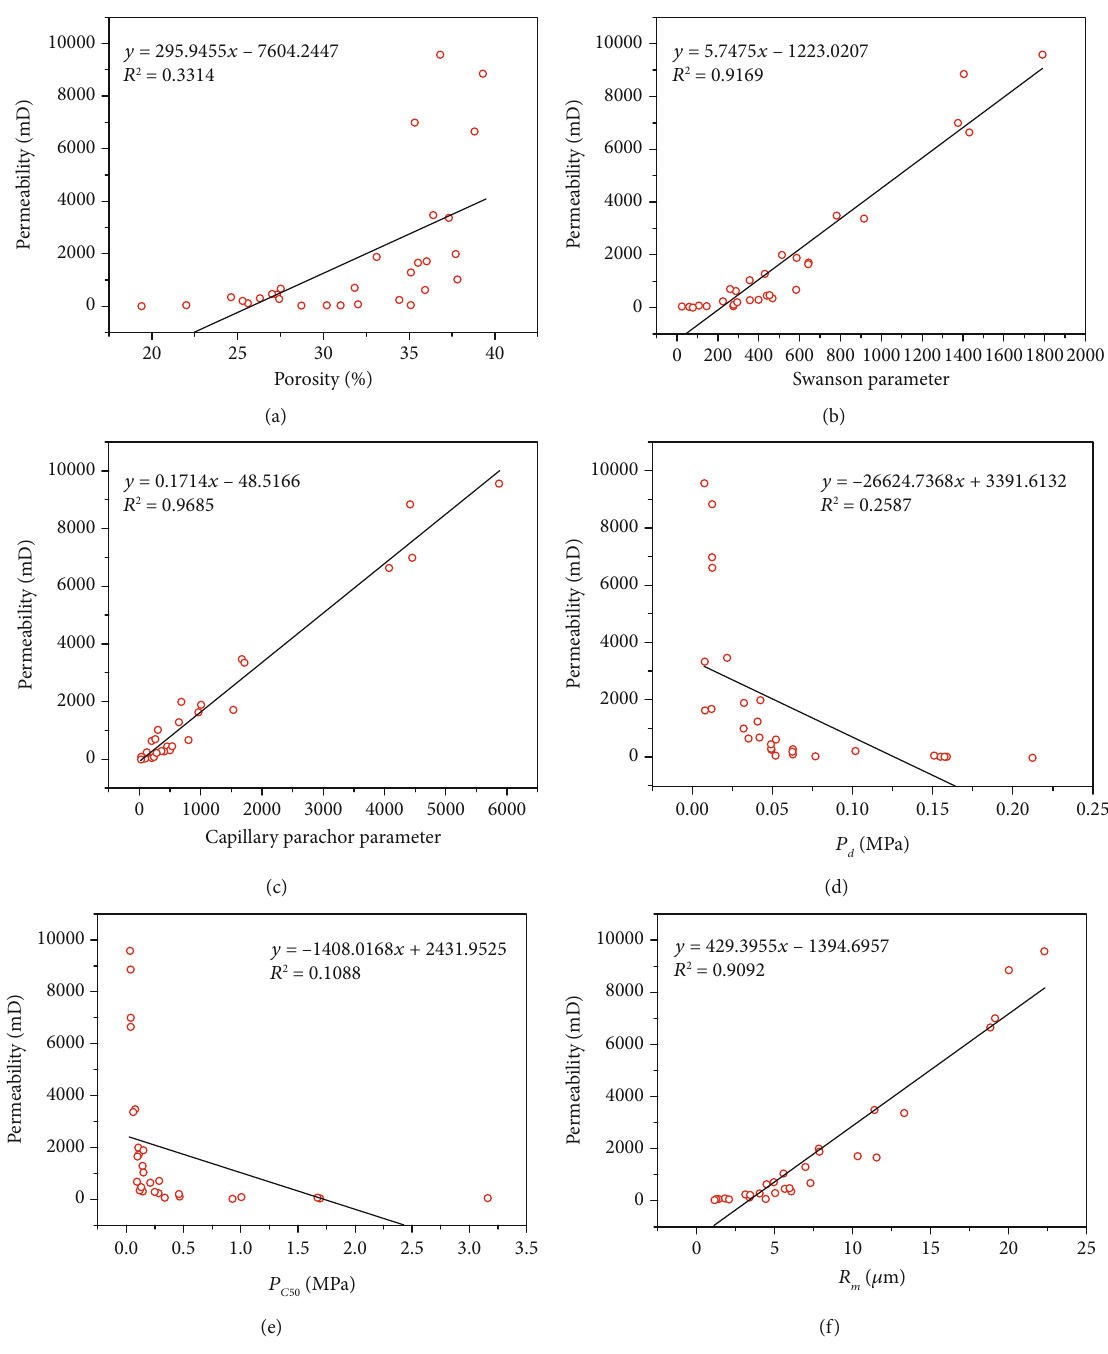
Figure 2: Cross plots of MICP parameters and permeability of rock samples: (a) porosity-permeability, (b) Swanson parameter permeability, (c) capillary parachor parameter permeability, (d) P